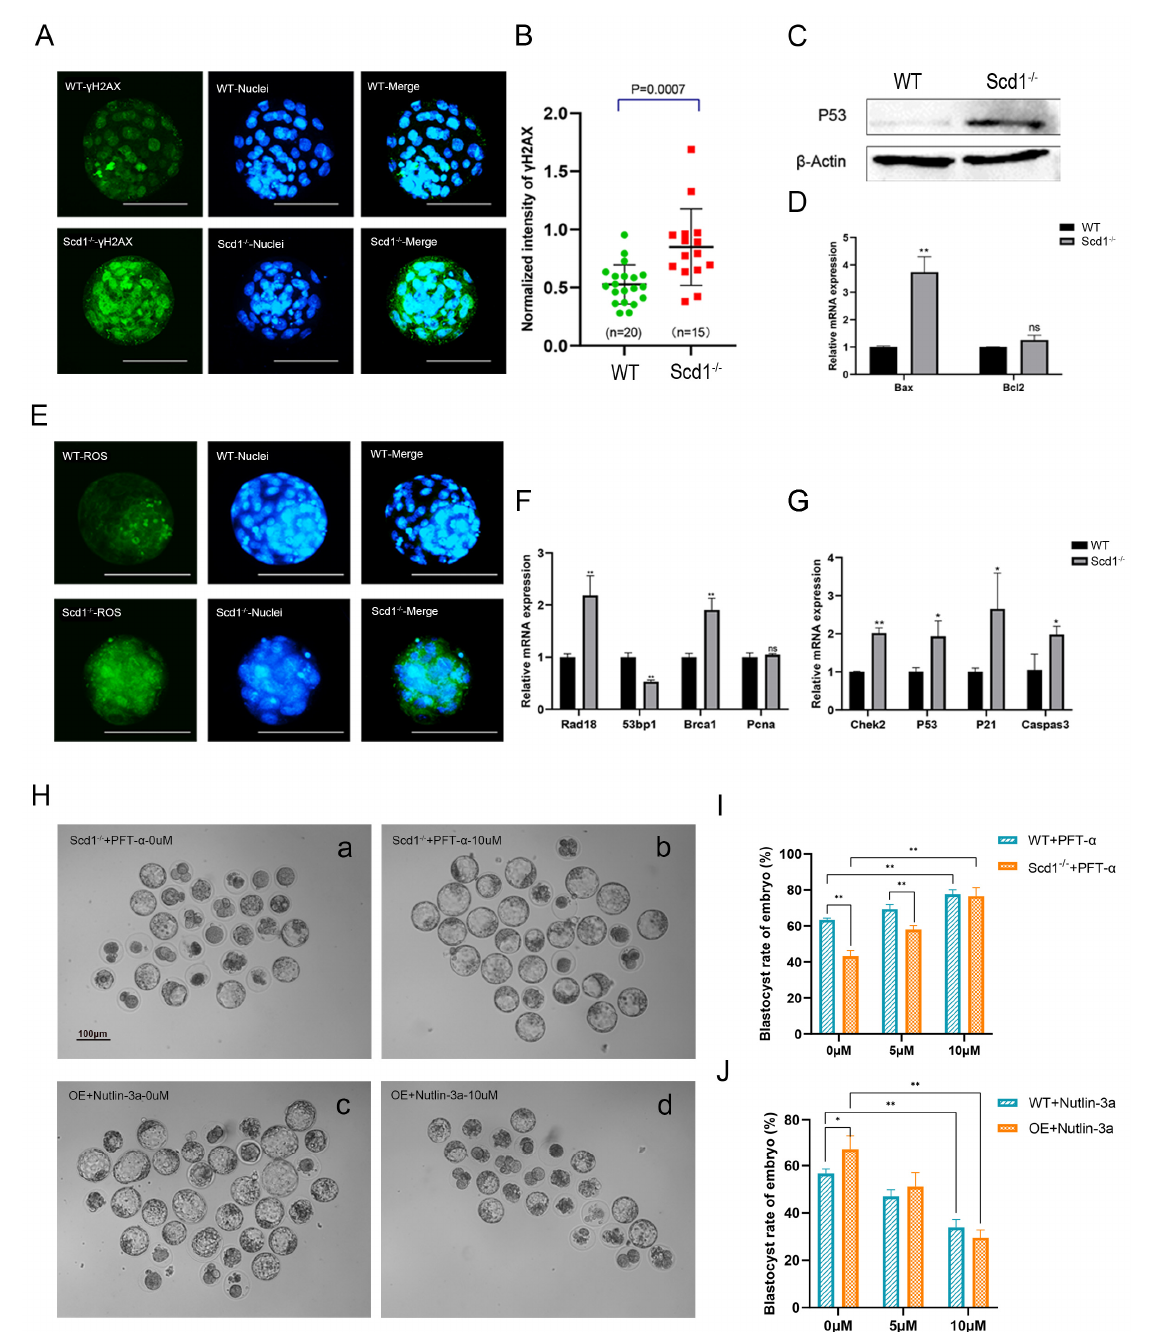
Figure 5. P53 inhibition rescues the blastocyst development in Scd1 − / − embryos. ( A ): Immunofluo- rescence assay of γ -H2AX level in WT and Scd1 − / − blastocysts. Scale bars, 75 μ m. ( B ): Immunofluo- rescence intensity analysis. n = number of embryos. ( C ): Detection of P53 protein expression using Western blot. ( D ): Expression level of apoptosis relative genes (Bax and bcl2). ( E ): Detection of reactive oxygen species (ROS) in WT and Scd1 − / − blastocysts. Scale bars, 100 μ m. ( F ): Relative gene expressions of DNA Post-replication modification and P53-pathway ( G ) in WT and Scd1 − / − blastocysts. * p < 0.05; ** p < 0.01, ( t -test). ( H ): ( a , b ): The blastocyst development rate of Scd1 − / − embryos with or without P53 pathway inhibitor PFT- α (10 µ M) treatment. ( c , d ): The blastocyst development rate of embryos after Scd1 overexpression (OE) with or without P53 pathway activator Nutlin-3a (10 µ M) treatment. Bar, 100 µ m. ( I ): The statistical analysis of ( H ) ( a , b ) and ( J ): ( H ) ( c , d ). The concentration of PFT- α and Nutlin-3a was 0 µ M, 5 µ M, 10 µ